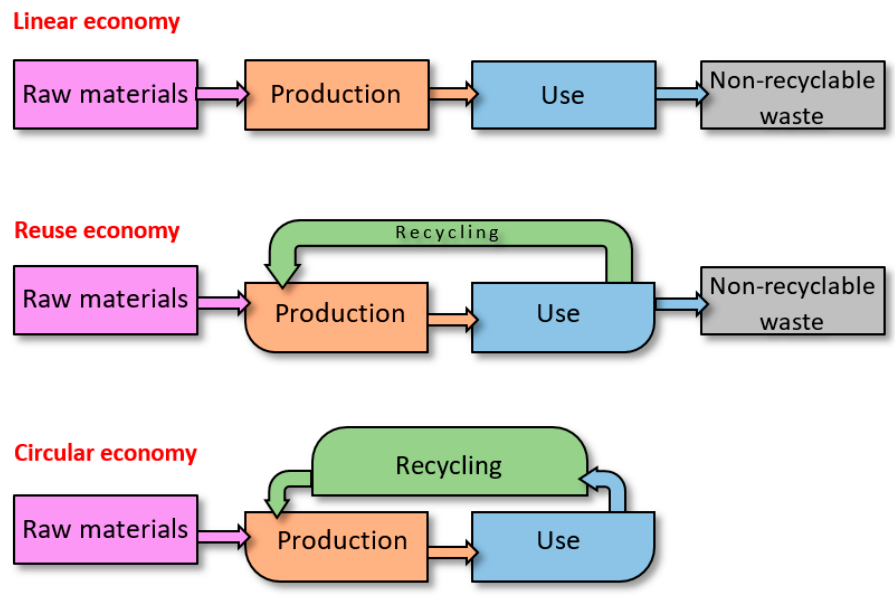
Figure 2. Diagram of linear and circular economy; source: own study based on [8].